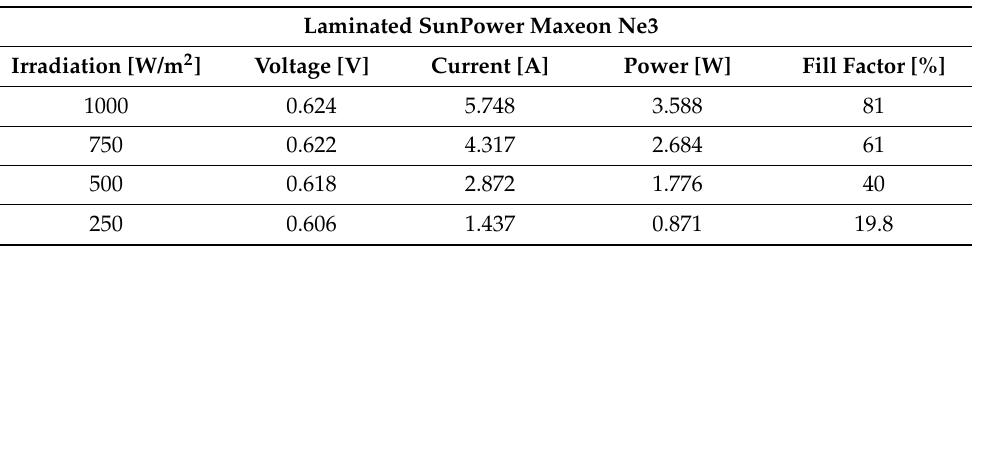
Figure 18. P-V and I-V characteristics of the laminated SunPower Maxeon Ne3 for different temperatures.